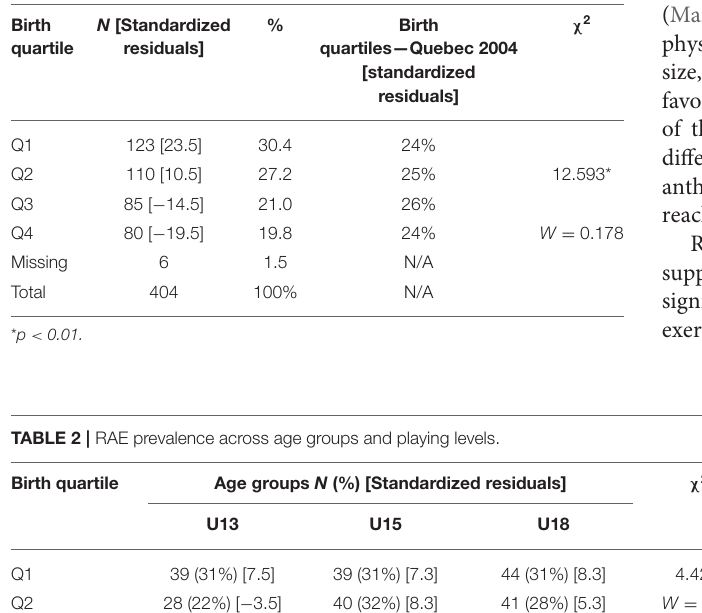
TABLE 1 | Birth quartiles in minor hockey compared with 2004 live births (Statistics Canada).